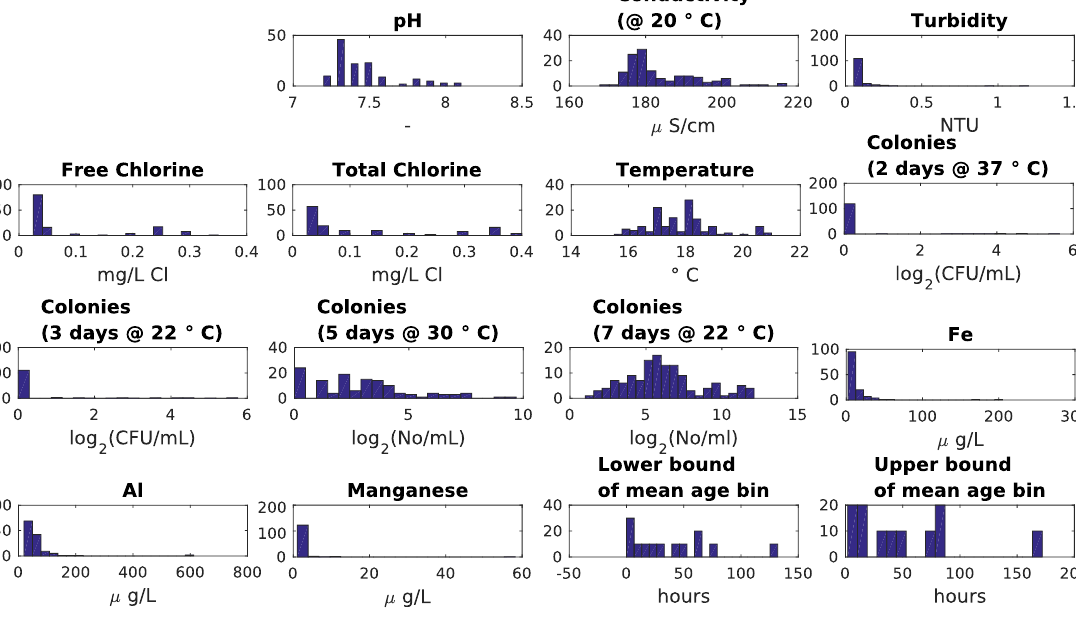
Figure 3. UK customer taps dataset data distribution.